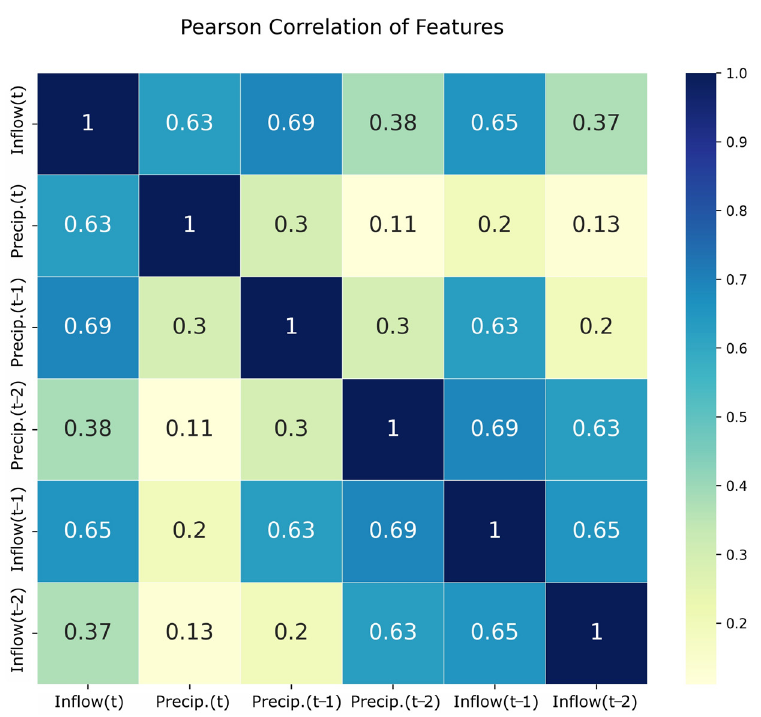
Figure 3. Heat map showing correlation for each input factor. Table 1. Dataset used to develop AS ensemble model.